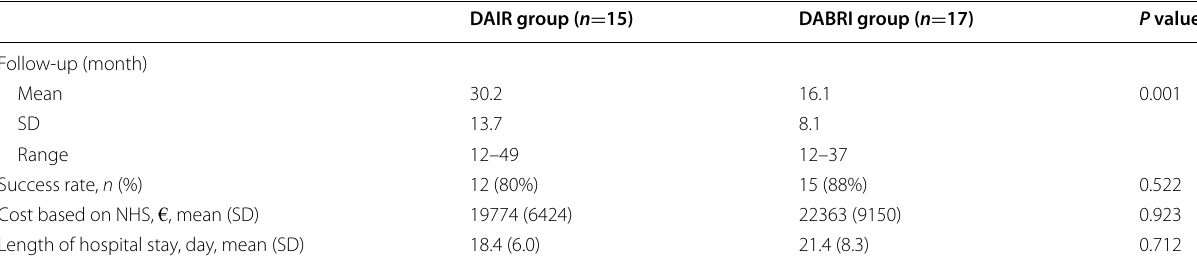
Table 2 Clinical results of 32 patients